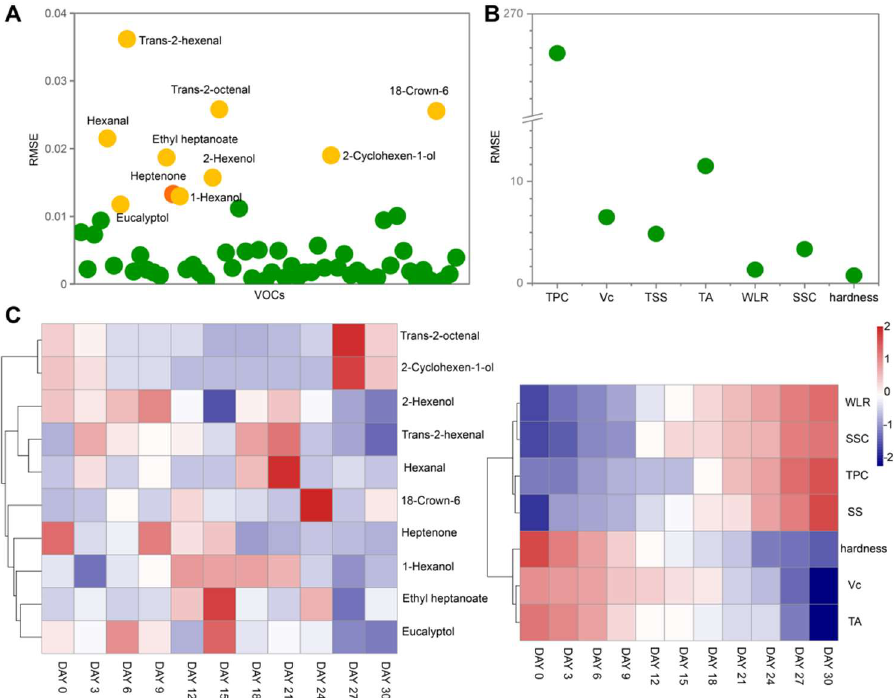
Figure 6. The relations between VFCs—storage time ( A ) and quality indexes—storage time ( B ) were analyzed using the nonlinear least square fit method. Heatmaps analysis of the selected 10 VFCs and all quality indexes with the extension of storage time ( C ).